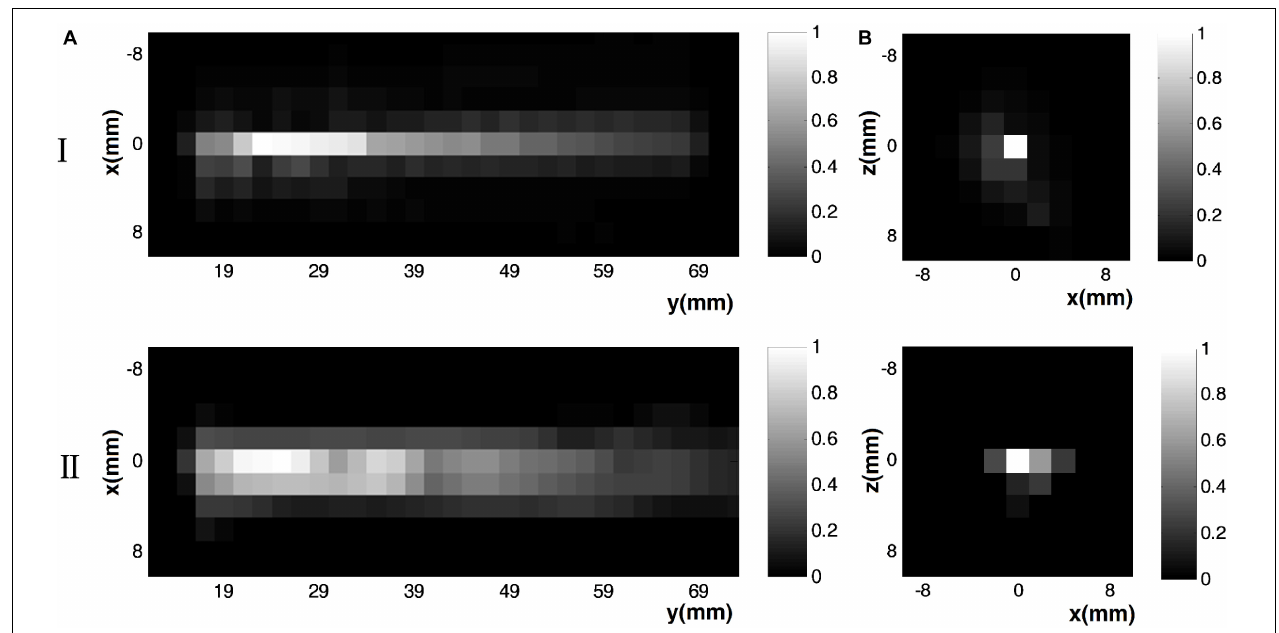
FIGURE 7 | Measurement results of (I) the ultrasound pressure field distribution and (II) the electrical field intensity distribution at (A) the x – y section ( y = 0 mm) and (B) x – z section ( y = 23 mm) by normalization.